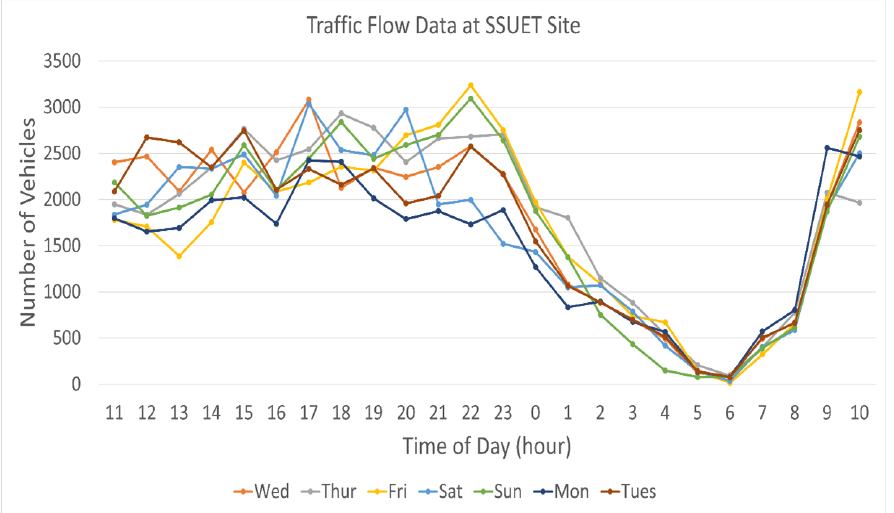
Figure 10. Weekly vehicle statistics collected at the SSUET site.